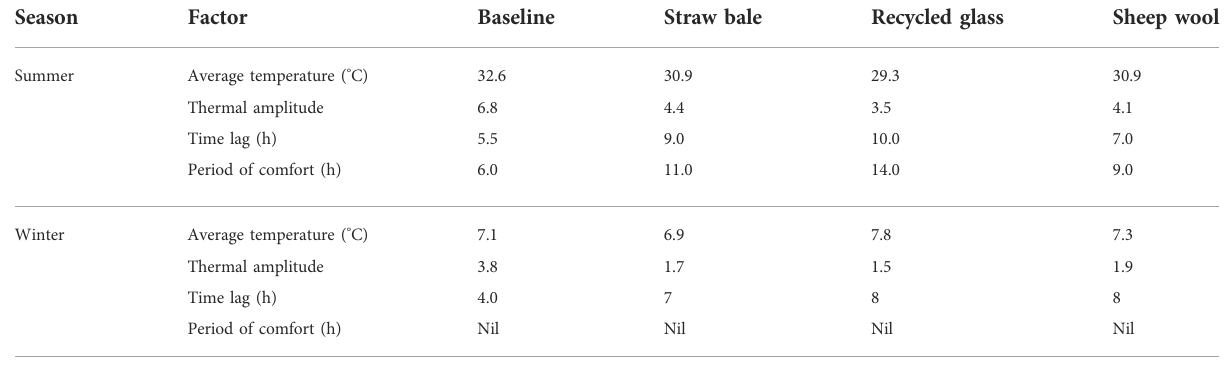
TABLE 4 Distribution of insulation materials on the rooftop.